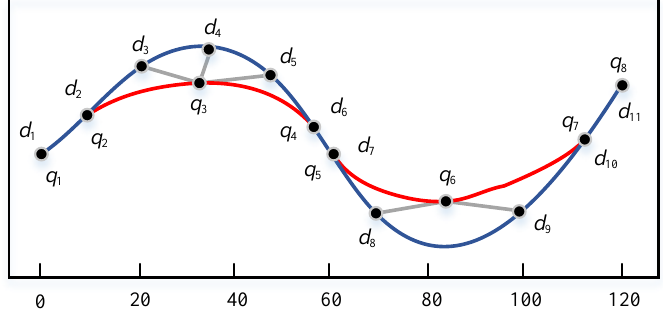
Figure 6. A projection comparison between two trajectory sequences in the window.